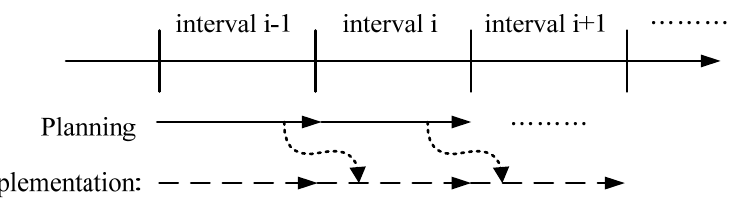
Figure 1. Procedure of microgrid operation